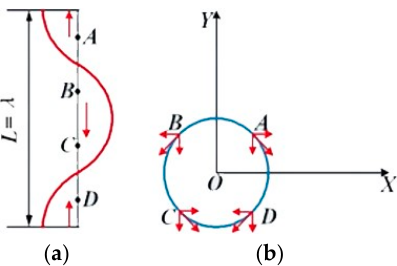
Figure 2. Current distribution on the spiral at t = 0. ( a ) the amplitude and direction of current on the unfolding spiral and ( b ) the amplitude and direction of current on circle spiral.